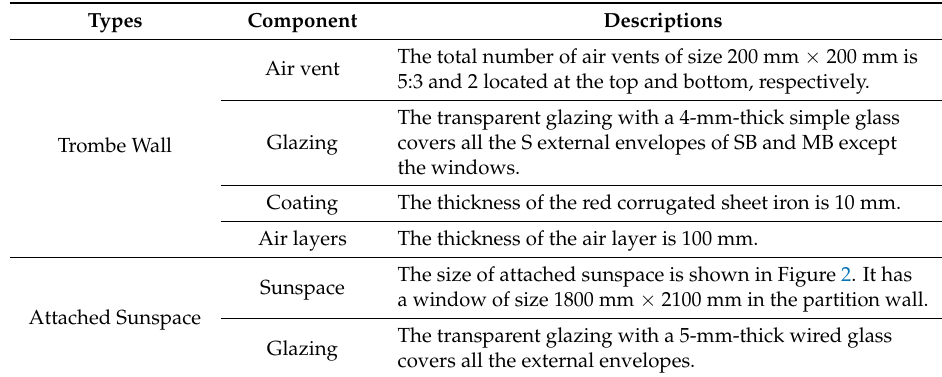
Table 2. The components of the passive solar houses.